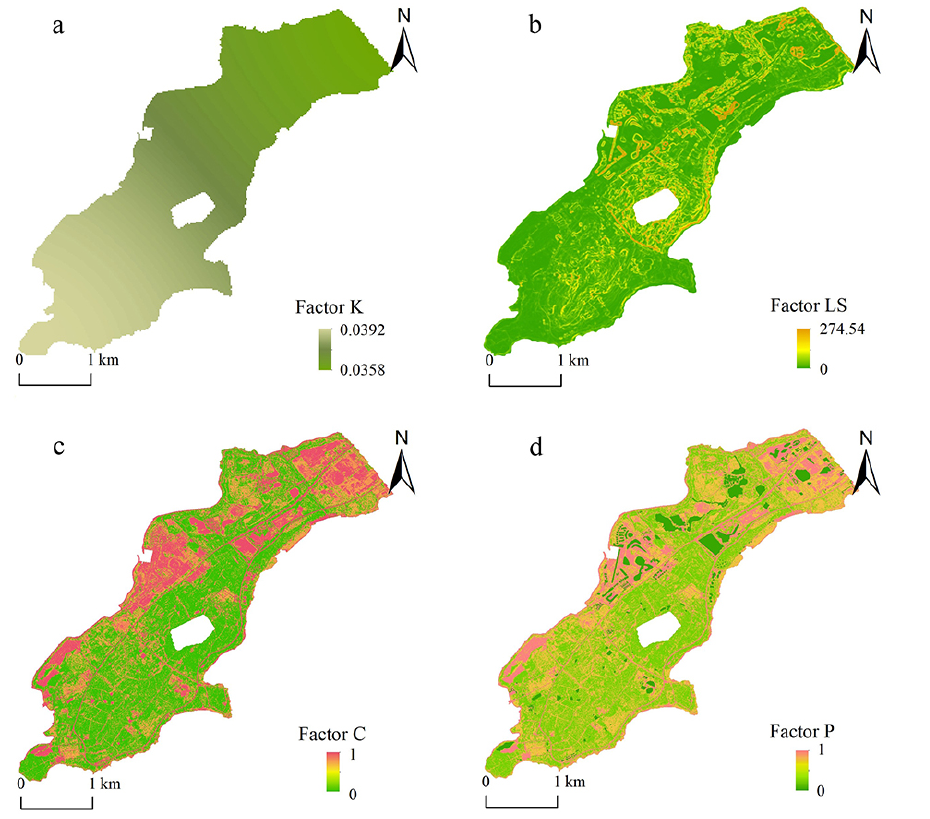
Figure 4. The spatial distribution of K factor ( a ), LS factor ( b ), C factor ( c ) and P factor ( d ) in the study